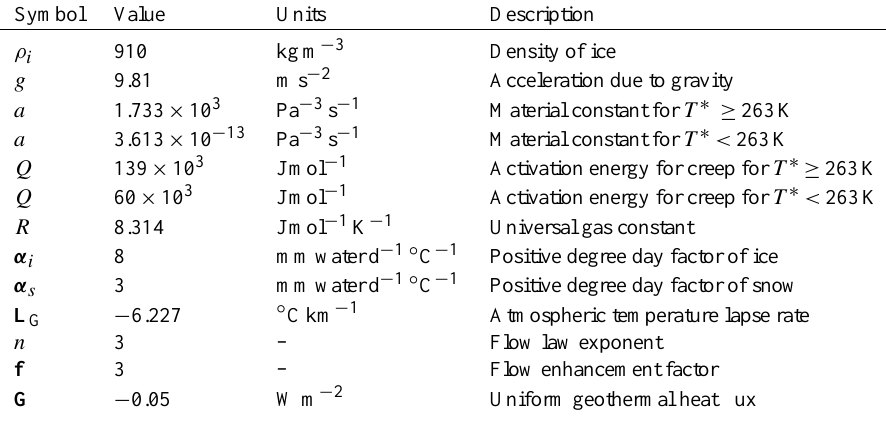
Table 1. List of default parameters and physical constants used in the model. Those highlighted in bold are varied in the tuning experiments (for a complete set see Rutt et al., 2009). Symbol Value Units Description ρ i 910 kgm − 3 Density of ice g 9.81 ms − 2 Acceleration due to gravity a 1.733 × 10 3 Pa − 3 s − 1 Material constant for T ∗ ≥ 263K a 3.613 × 10 − 13 Pa − 3 s − 1 Material constant for T ∗ < 263K Q 139 × 10 3 Jmol − 1 Activation energy for creep for T ∗ ≥ 263K Q 60 × 10 3 Jmol − 1 Activation energy for creep for T ∗ < 263K R 8.314 Jmol − 1 K − 1 Universal gas constant α i mmwaterd − 1 ◦ C − 1 Positive degree day factor of ice mmwaterd − 1 ◦ C − 1 Positive degree day factor of snow L G − 6.227 ◦ Ckm − 1 Atmospheric temperature lapse rate n 3 – Flow law exponent f 3